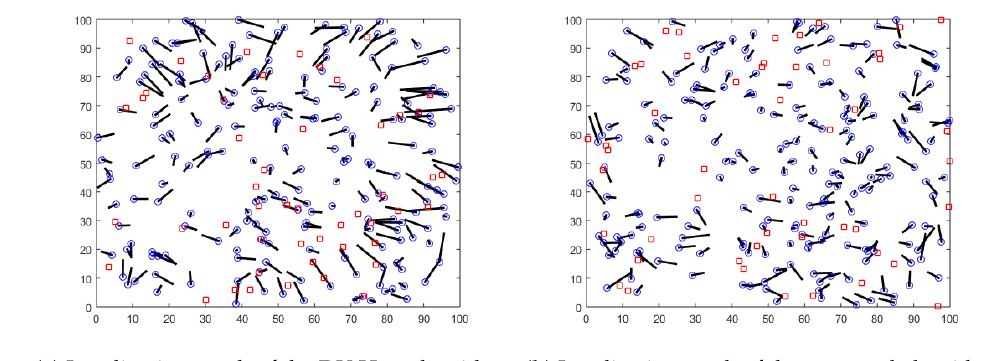
Figure 5. Localization results with random deployment of anchors.